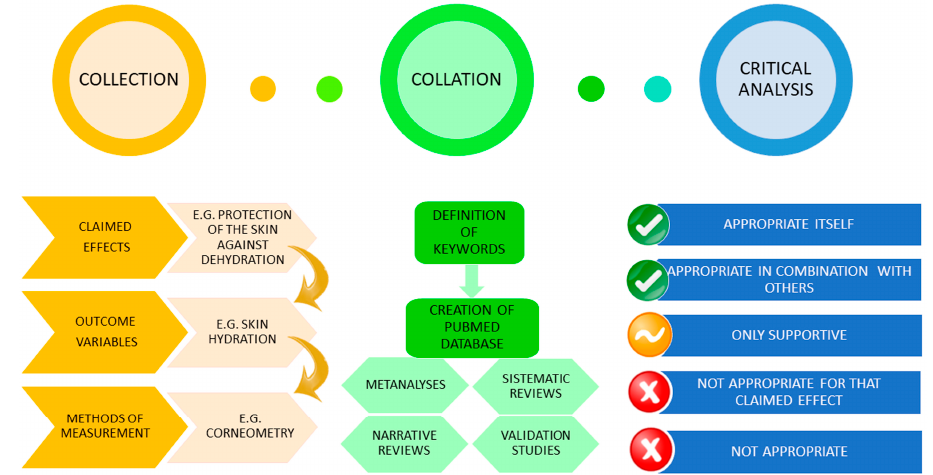
Figure 1. Collection, collation and critical evaluation of information in relation to claimed effects, outcome variables and methods of measurement in the framework of maintenance of skin function: flow chart of the project.